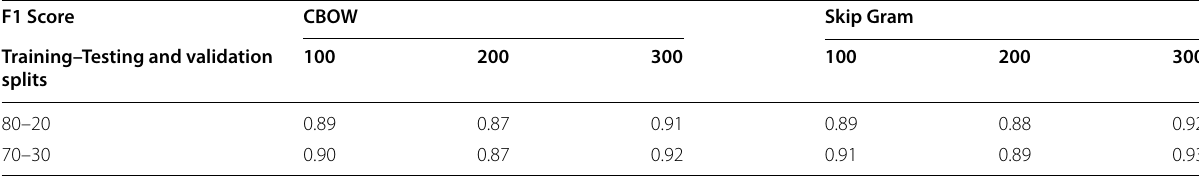
Table 11 F1 score values of the proposed model F1 Score CBOW Training–Testing and validation splits